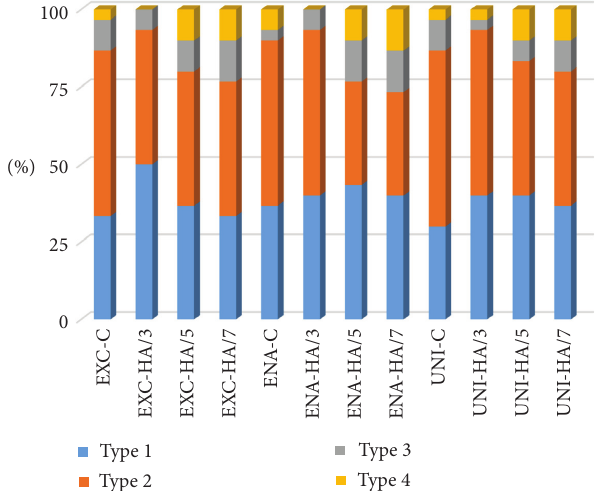
Figure 1: Distribution (%) of failure mode in experimental groups after the microtensile bond strength test. Type 1, adhesive fracture between adhesive agent and dentin; type 2, adhesive fracture be- tween adhesive agent and dentin plus partial cohesive fracture in the composite restoration or dentin (mixed failure); type 3, co- hesive fracture in dentin; and type 4, cohesive fracture in the composite restoration. EXC, ExciTE F DSC; ENA, ENA Bond; UNI, Scotchbond Universal; C, control group; HA/3, hydro- abrasion group at 3 bar; HA/5, hydroabrasion group at 5 bar; HA/7, hydroabrasion group at 7 bar.